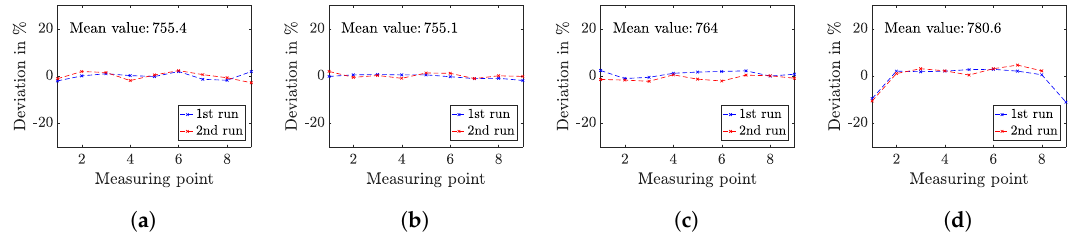
Figure 3. Variation of the hardness measurements by indicating the deviation from the mean value of the individual samples ( a ) A1, ( b ) A2, ( c ) A3, ( d ) A4.